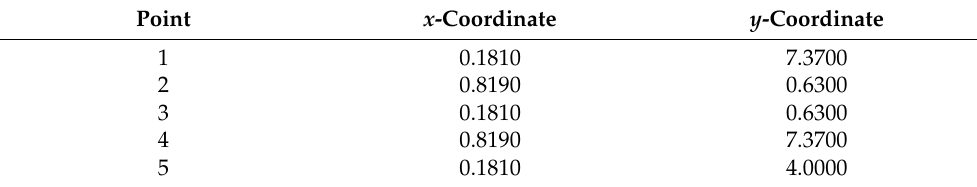
Table 3. ND Coordinates for the time history points shown in Figure 3. Point x -Coordinate y